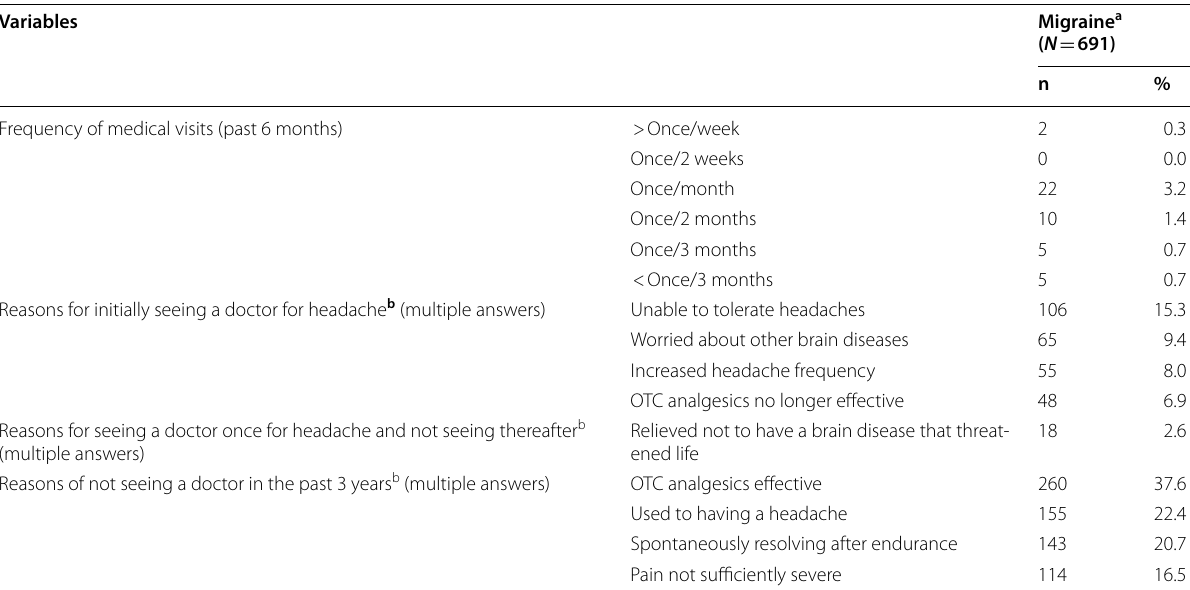
Table 3 Summary of medical visits in people with